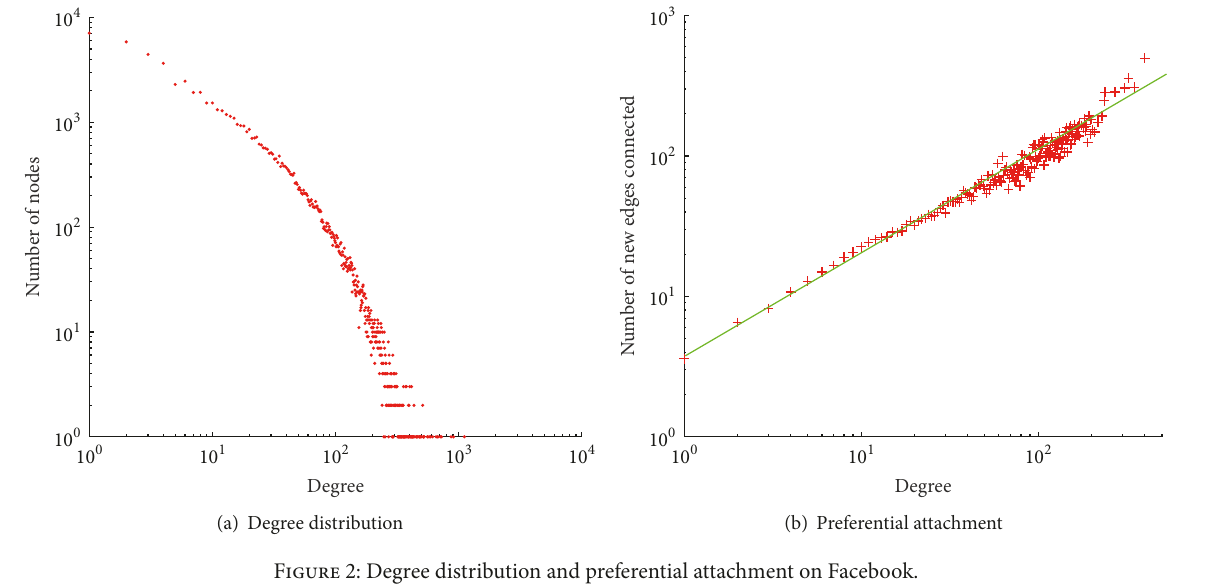
Figure 2: Degree distribution and preferential attachment on Facebook.